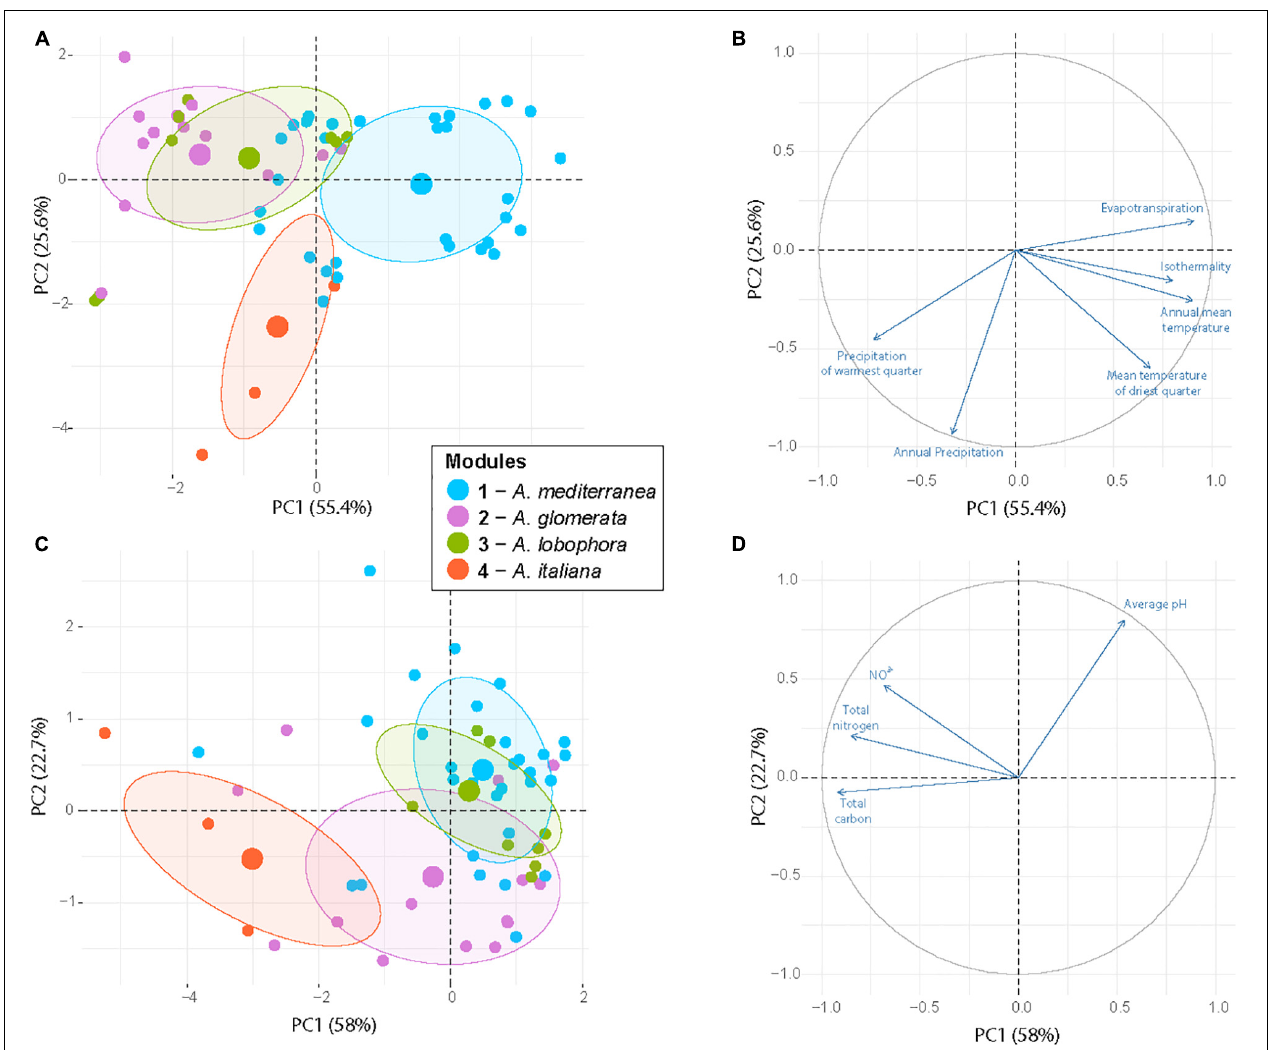
FIGURE 7 | Principal component analysis of the sampling sites based on six climatic variables (A,B) and four soil properties (C,D) that significantly differ between the photobiont-mycobiont modules. Large circles represented group centroids. The modules are distinguished by color.